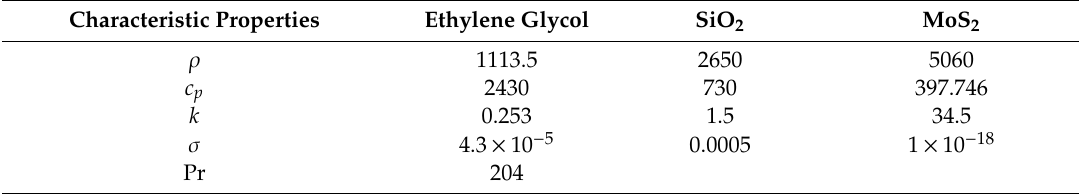
Table 2. The thermophysical properties of the base fluid (ethylene glycol) and the ethylene glycol hybrid nanoparticles [35,36].